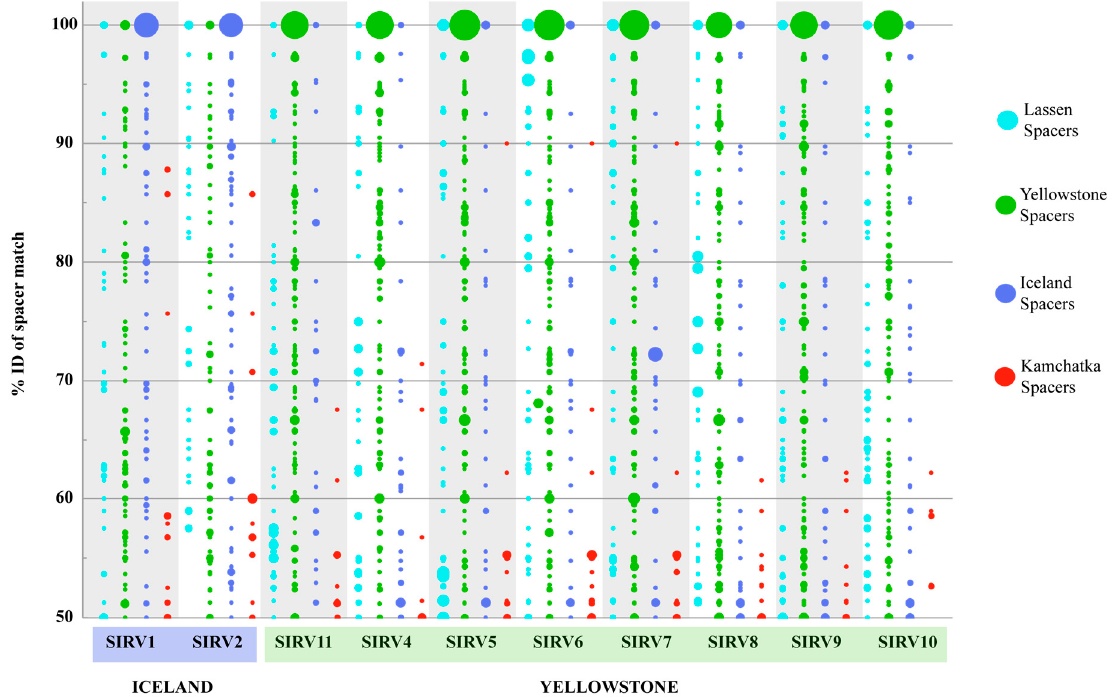
Figure 5. CRISPR spacer matches of spacers from S. islandicus strains from different geographical locations to SIRVs from Yellowstone and Iceland. Only matches with >50% identity are shown. Diameter of circles indicates the number of matches at that % identity. Smallest circle represents one match, largest circle represents 48 matches.